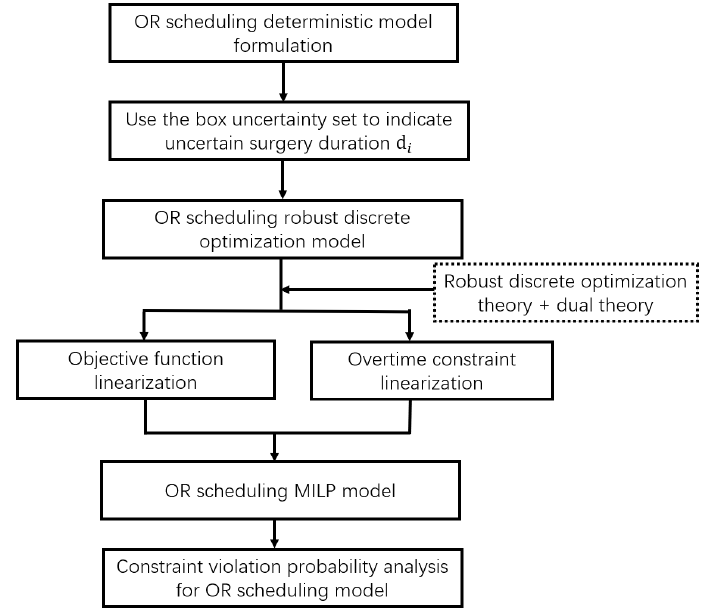
Figure 1. Flowchart of OR scheduling research